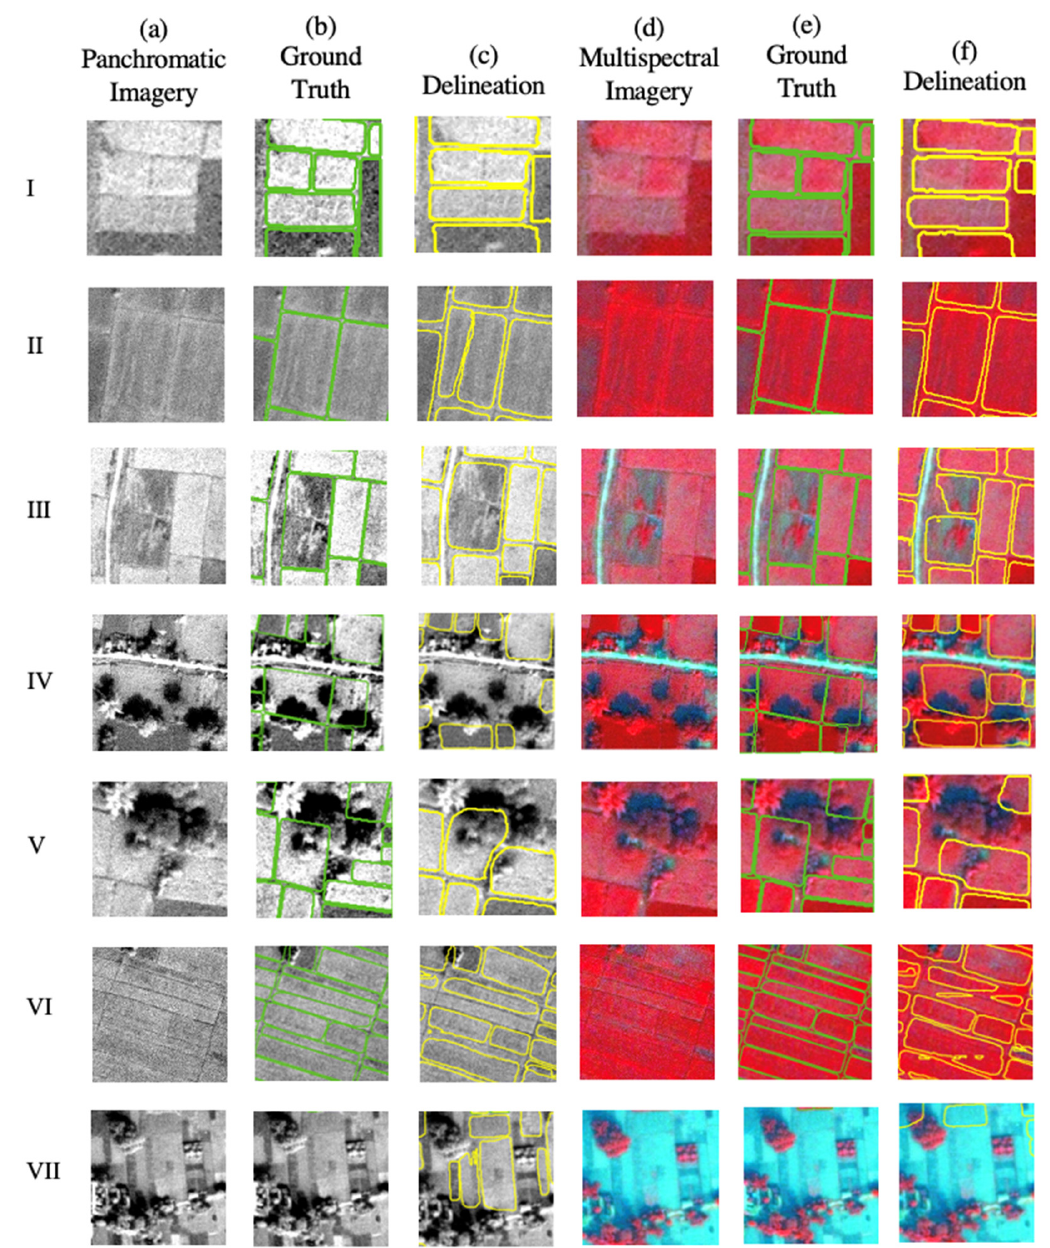
Figure 6. Examples of common issues ( I – VII , detailed in text) across different model results (columns ( a – f )) from Bihar. Green lines represent ground truth boundaries, and yellow lines represent predicted boundaries for panchromatic and multispectral imagery, respectively.